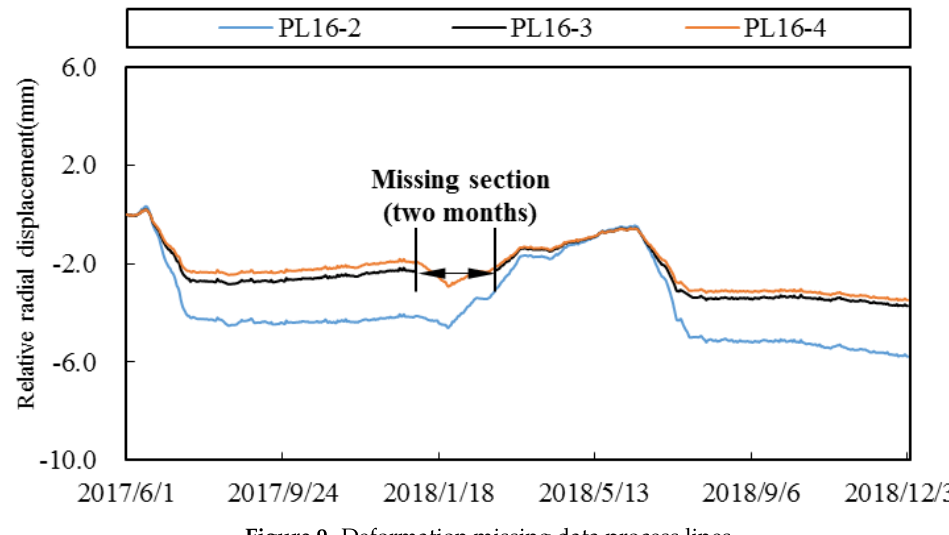
Figure 9. Deformation missing data process lines.